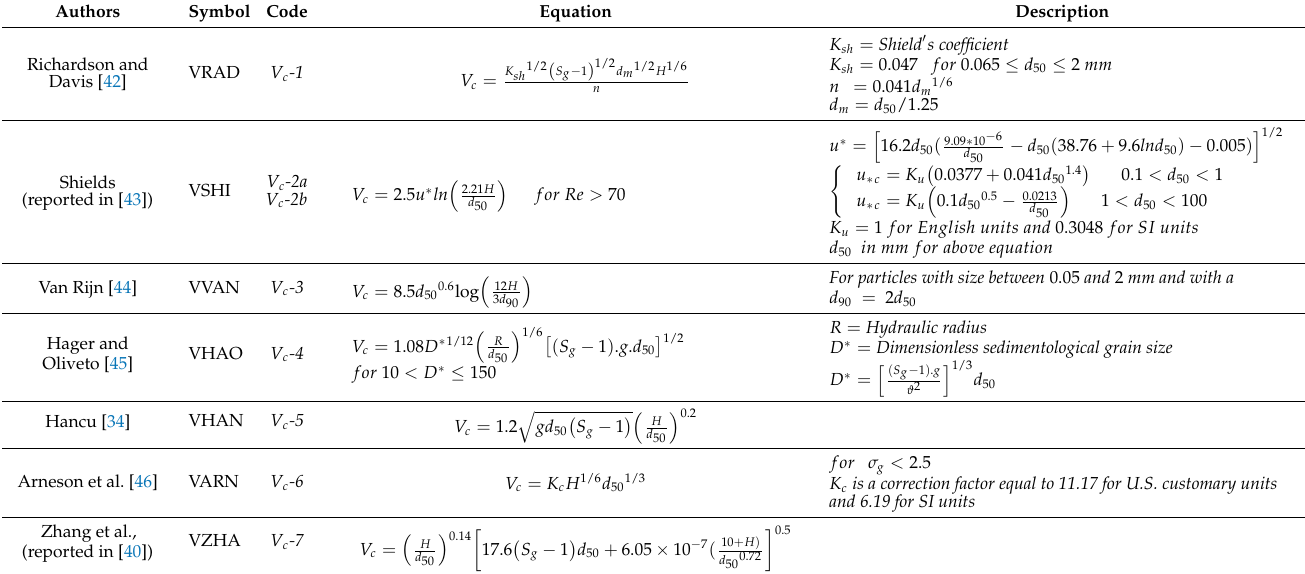
Table 2. Critical velocity estimation